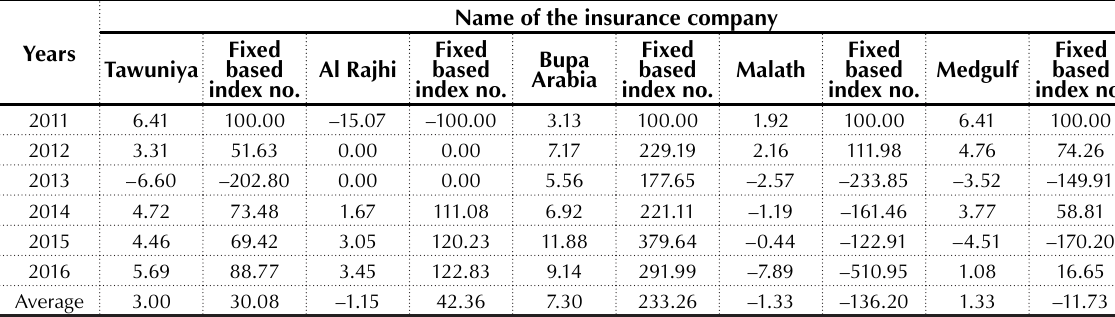
Table 3. Return on assets (ROA) (ratios are in percentage) Years